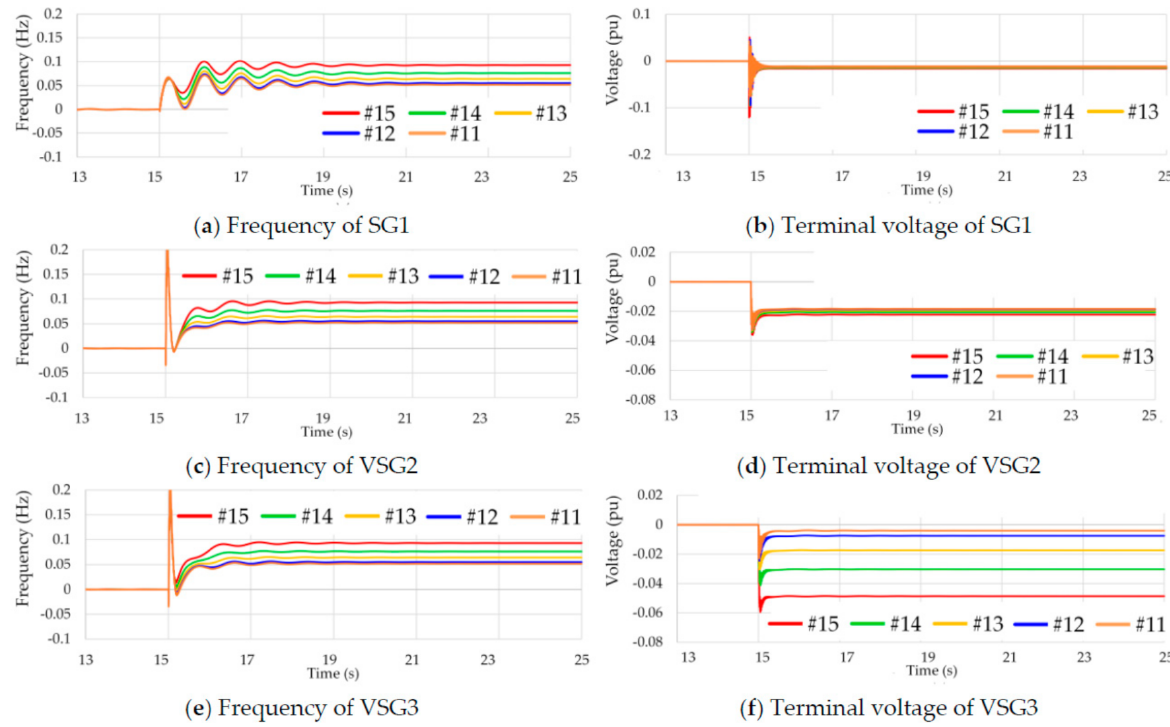
Figure 5. Transient responses of the frequency and voltage for tests 6–10 in Table 1.